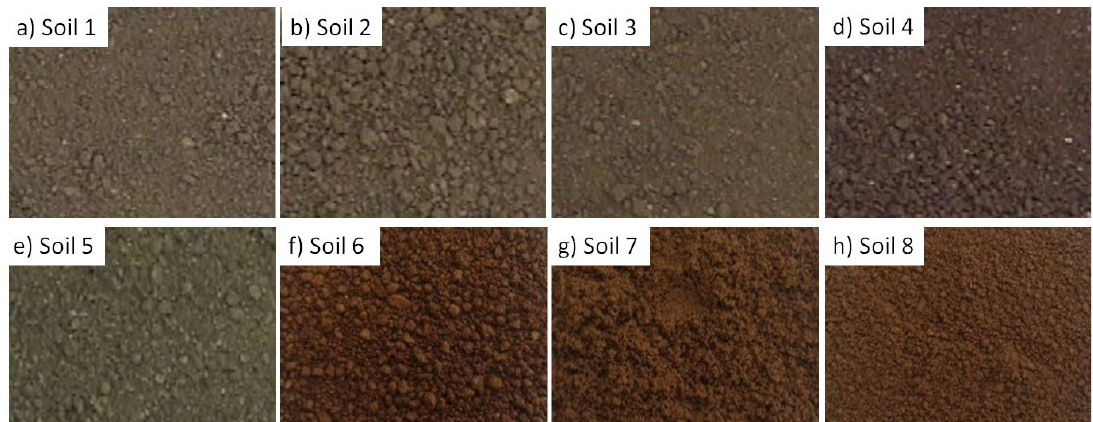
Figure 3. Photos of eight soil samples collected in different regions. Soil 1 to soil 5 collection in Rio de Janeiro and soil 6 to soil 8 collection in São João del